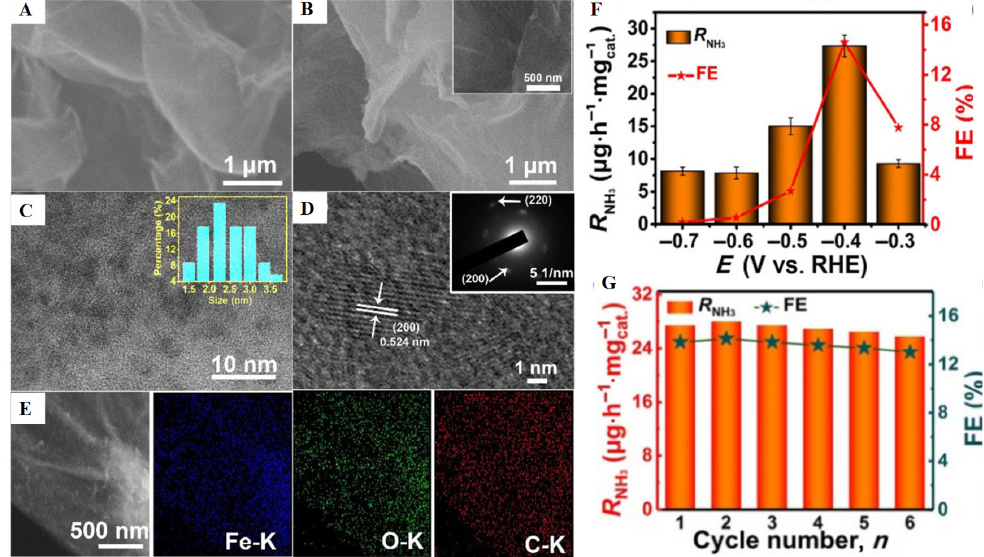
Figure 5. Scanning electron microscopy images of ( A ) GS and ( B ) FeOOH Quantum Dots ‐ GS. ( C ) TEM image of FeOOH QDs ‐ GS. ( D ) SAED and HRTEM images. ( E ) EDX elemental mapping & SEM images of carbon, iron, and oxygen in FeOOH Quantum Dots ‐ GS. ( F ) Fes and RNH 3 for FeOOH Quantum dots ‐ GS/CP under different yields at − 0.4 V using different electrode. ( G ) Recycle test of FeOOH Quantum dots ‐ GS/CP at − 0.40 volt [31].